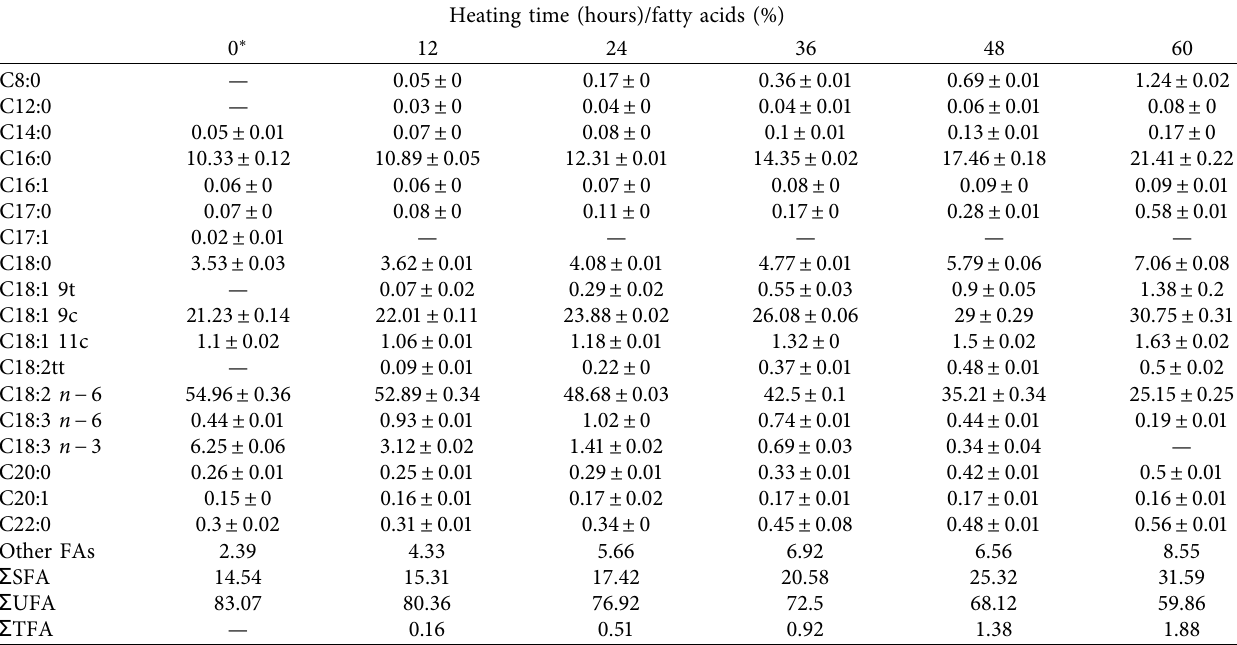
Table 6: Variation of fatty acids of soybean oil under 240 ° C heating temperature at different heating